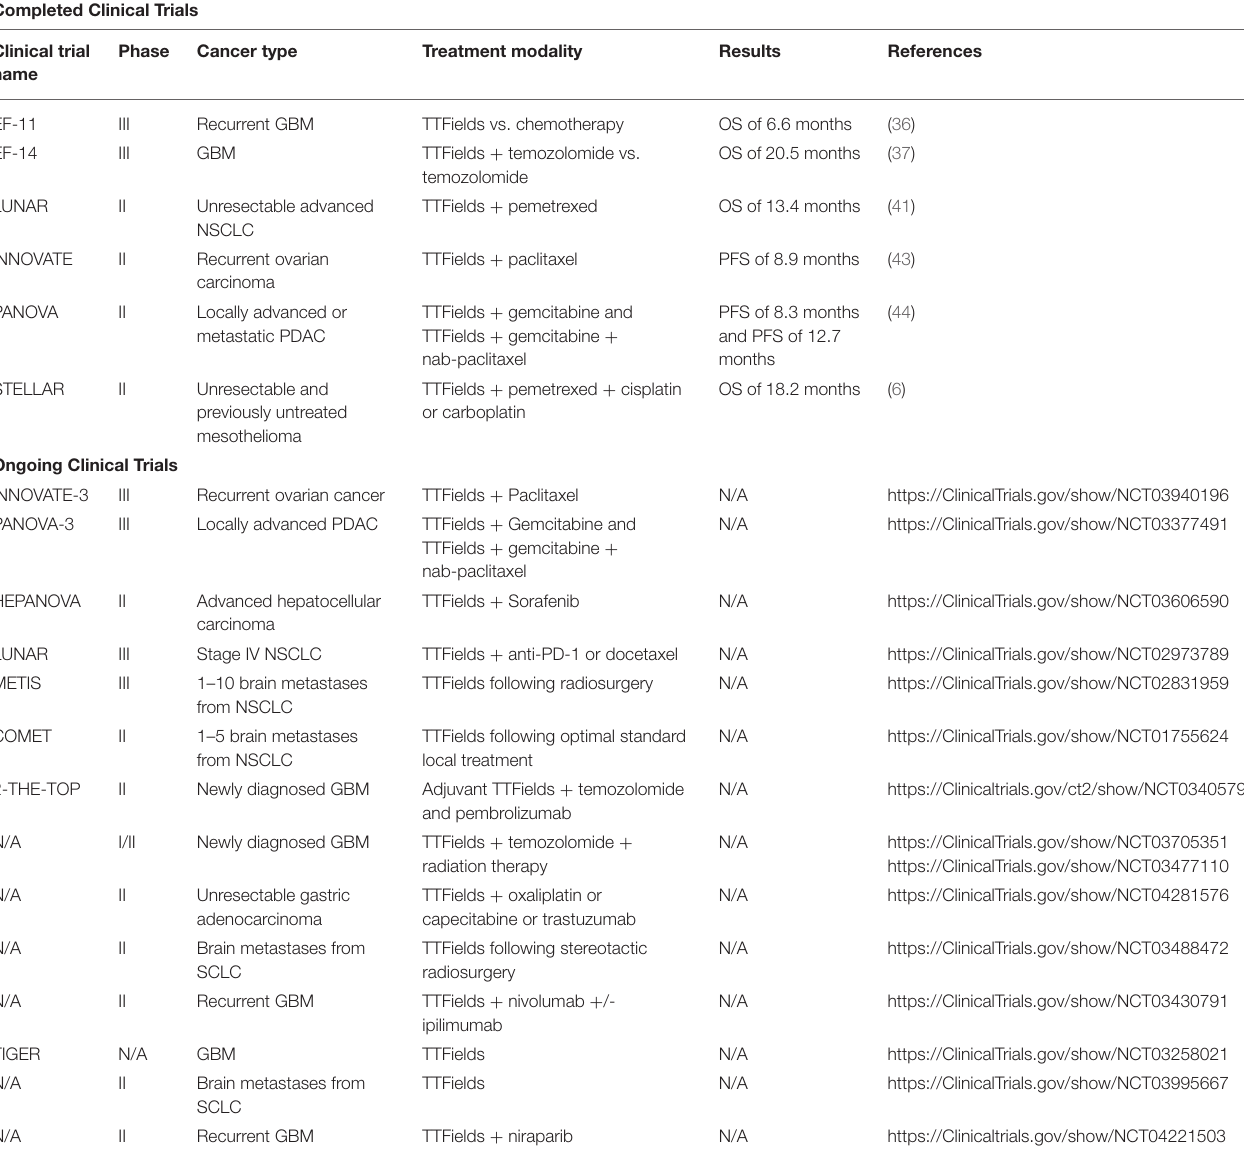
TABLE 1 | Summary of completed and ongoing clinical trials using TTFields as monotherapy or in combination with other therapeutic agents to treat solid malignancies. Completed Clinical